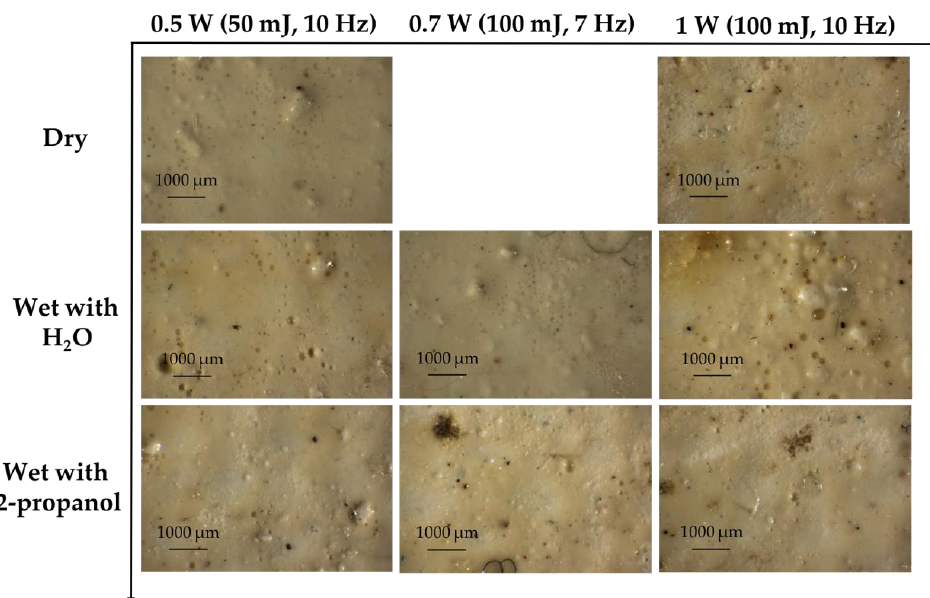
Figure 12 Figure 12. The microscopic images (32 × ) of the eight sections of mastic varnished lead white tempera mock-ups after different laser cleaning conditions and parameters.